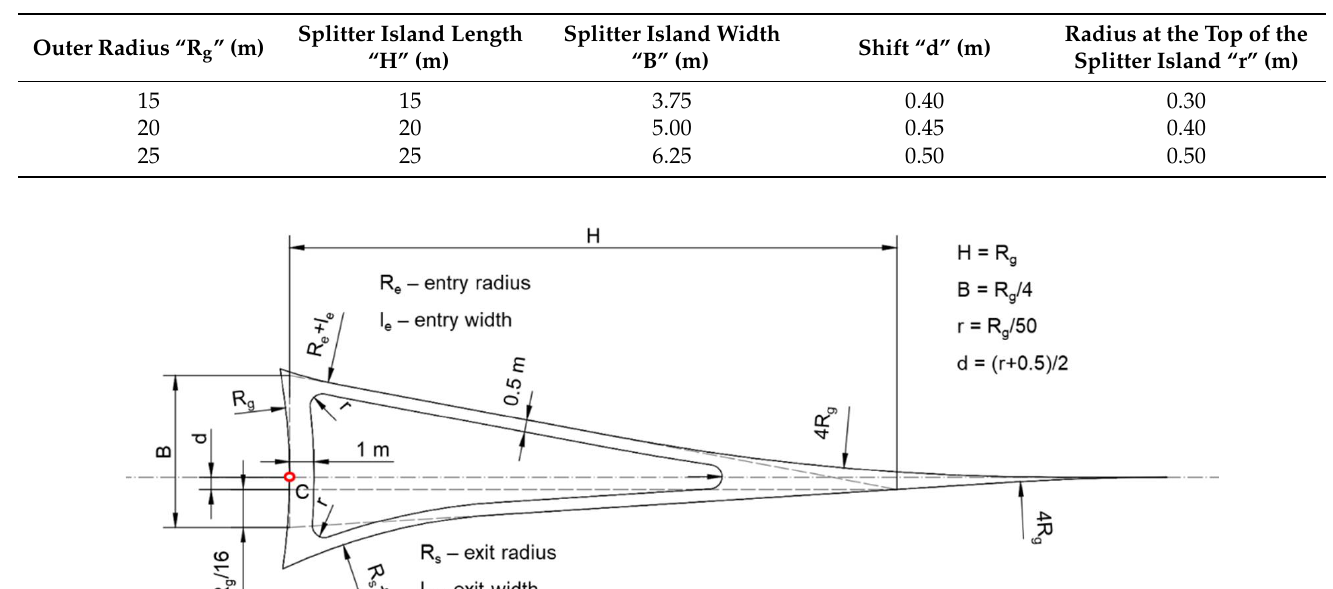
Table 4. Splitter island elements according to [6].